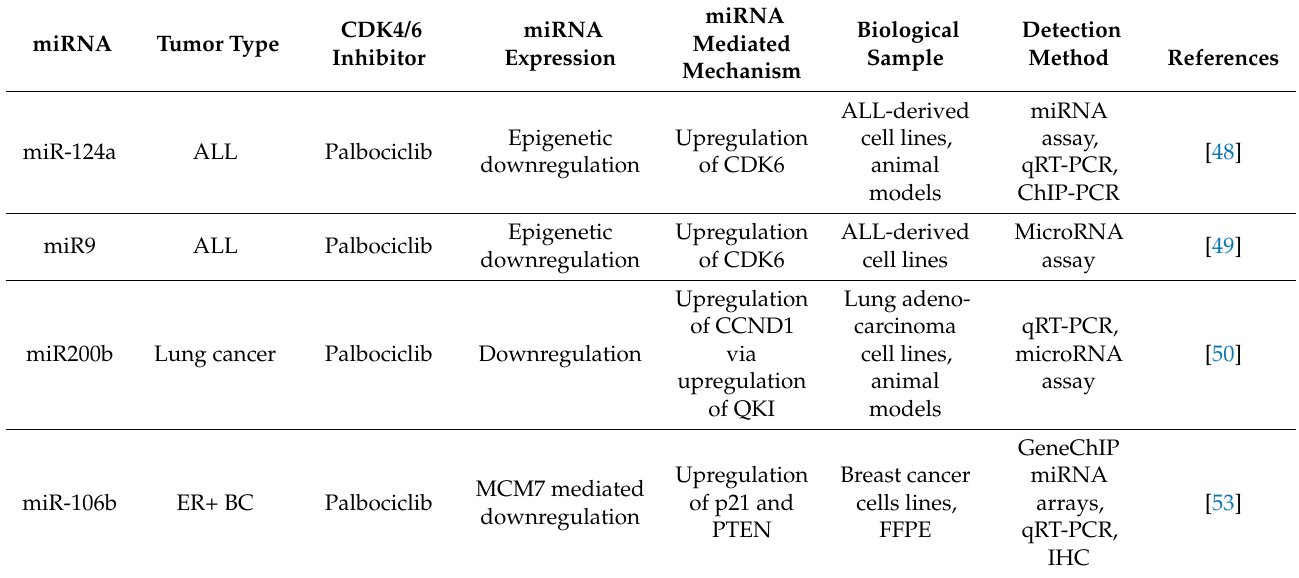
Table 3. MicroRNAs that mediate antitumor response to CDK4/6